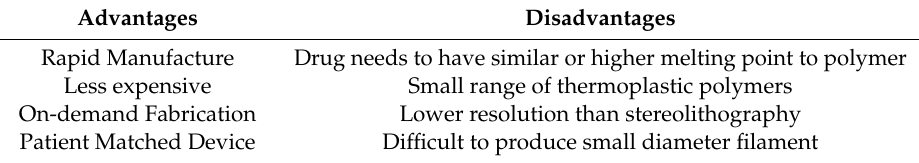
Table 1. Table summarising advantages and disadvantages of fused deposition modelling. Advantages